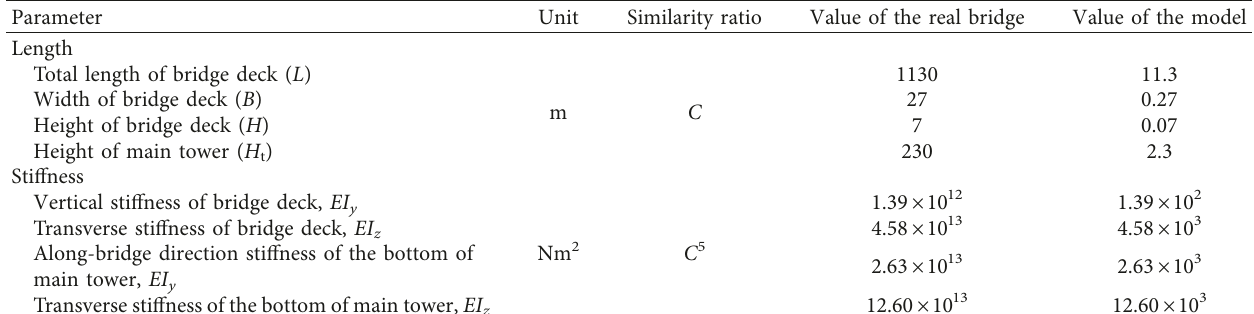
Table 6: Major design parameters of the full-bridge aeroelastic model.